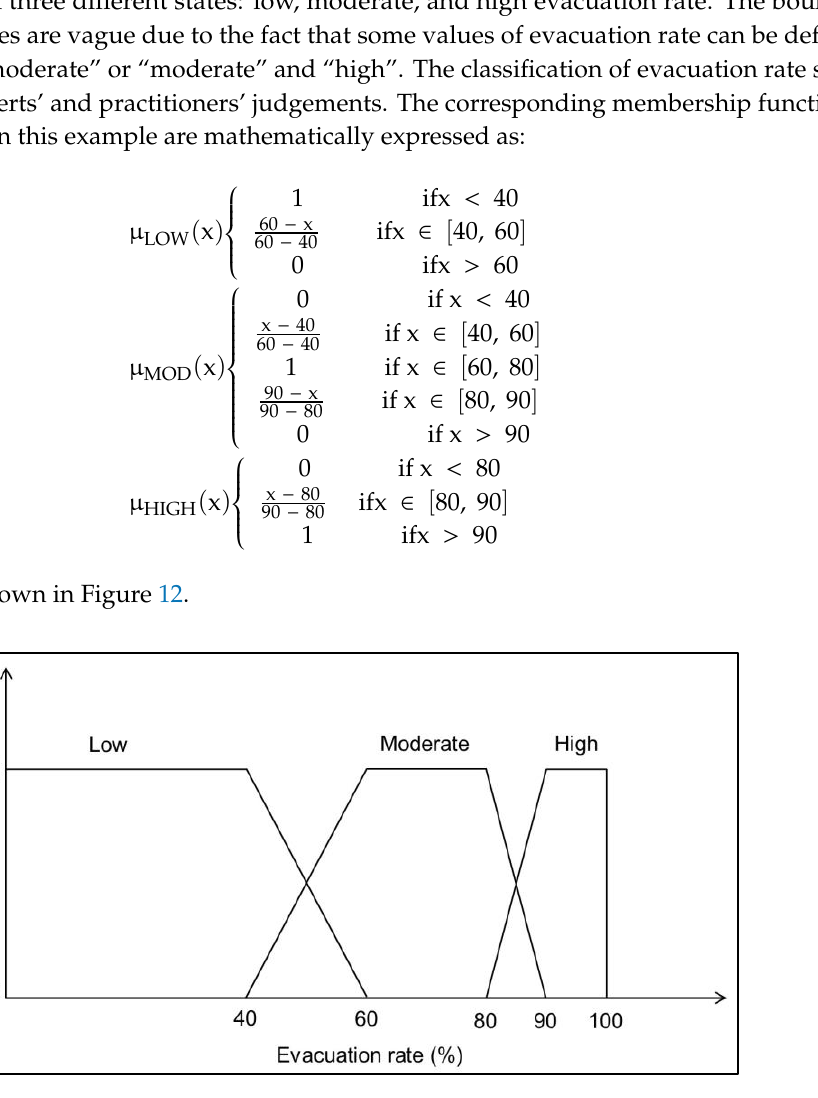
Figure 12. Fuzzy membership functions of the variable “Evacuation efficiency”.